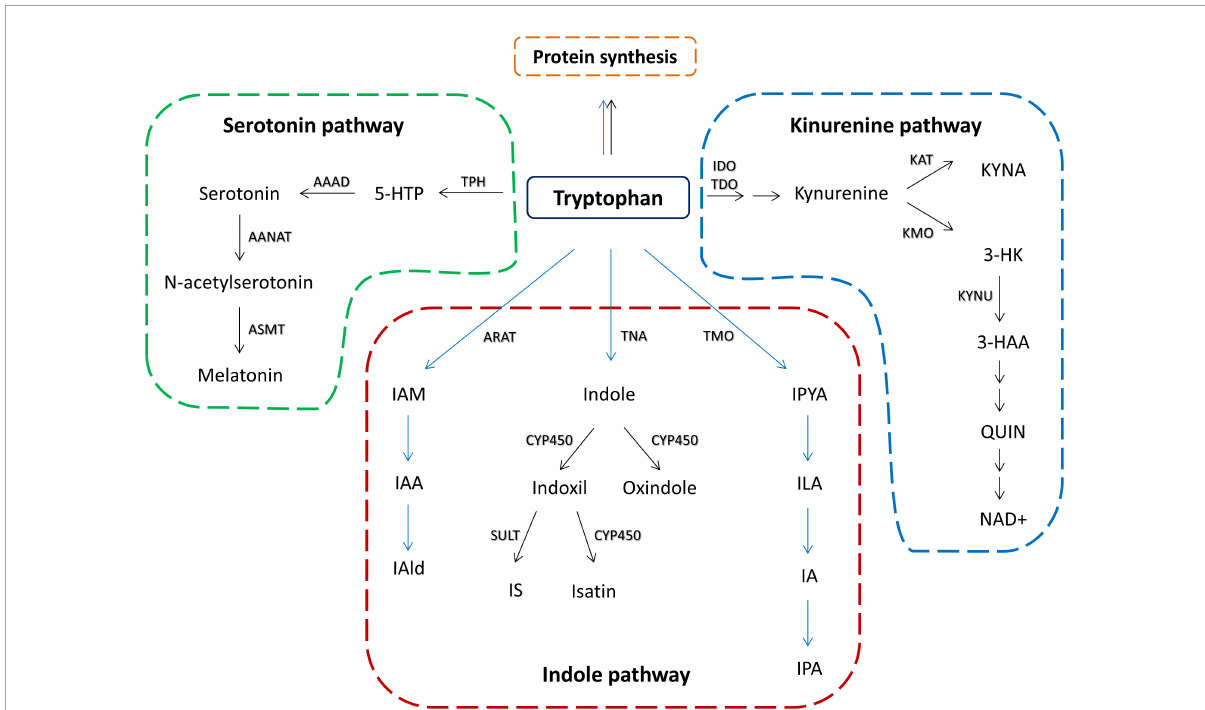
FIGURE1 Schematic overview of tryptophan metabolic pathways in the host and its commensal bacteria. Black arrows represent host metabolism. Blue arrows represent microbial metabolism. Serotonin pathway – TPH, tryptophan hydroxylase; 5-HTP, 5-hydroxytryptophan; AAAD, aromatic amino acid decarboxylase; AANAT, aralkylamine N -acetyltransferase; ASMT, acetylserotonin O -methyltransferase; kynurenine pathway – IDO, indolamine 2,3-dioxygenase; TDO, tryptophan 2,3-dioxygenase; KAT, kynurenine aminotransferase; KYNA, kynurenine acid; KMO,